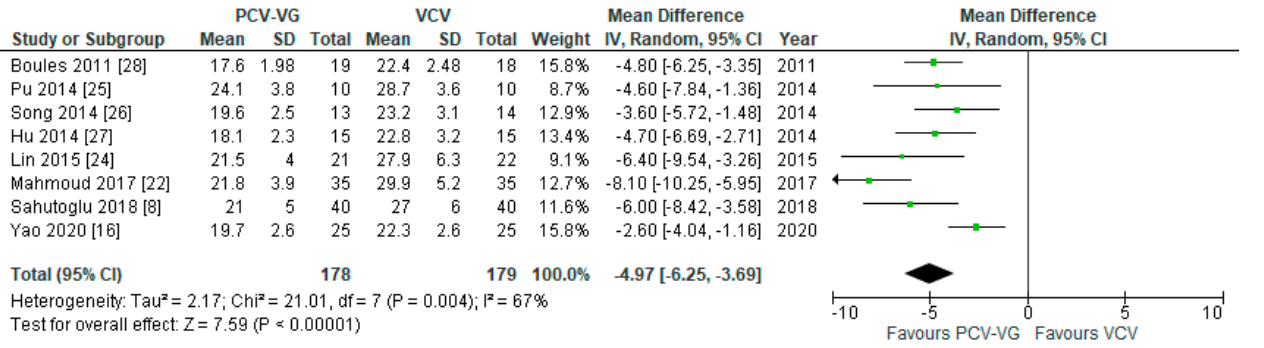
Figure 10. Peak airway pressure (P peak ): after 20–60 min of one-lung ventilation. The green center of each square represents the weighted mean difference for individual trials, and the corresponding horizontal line stands for a 95% confidence interval. The diamonds represent pooled results.